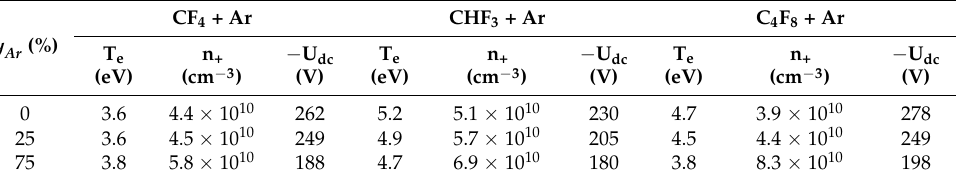
Table 1. Electron- and ion-related plasma parameters in CF 4 + Ar, CHF 3 + Ar and C 4 F 8 + Ar plasmas at p = 6 mTorr, W = 700 W and W dc = 200 W